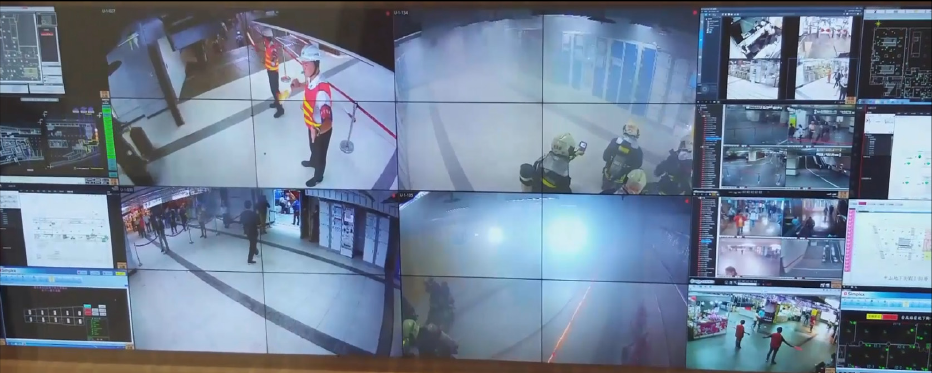
Figure 18. Drill on national disaster prevention day in specific areas of Taipei Main Station. (Source: Taipei Main Station Intelligent Joint Disaster Prevention Center, 2021).